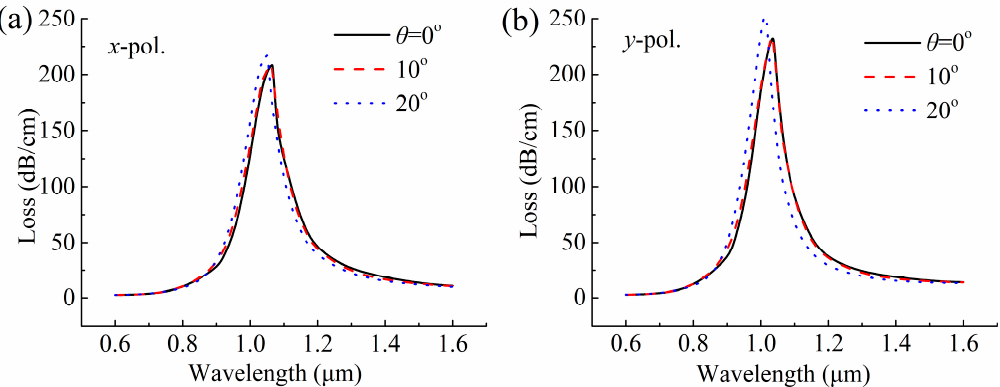
Figure 6. Losses as a function of wavelength for the ( a ) x -polarized and ( b ) y -polarized core modes at n = 1.47, with varying nanowire positions ( θ ).